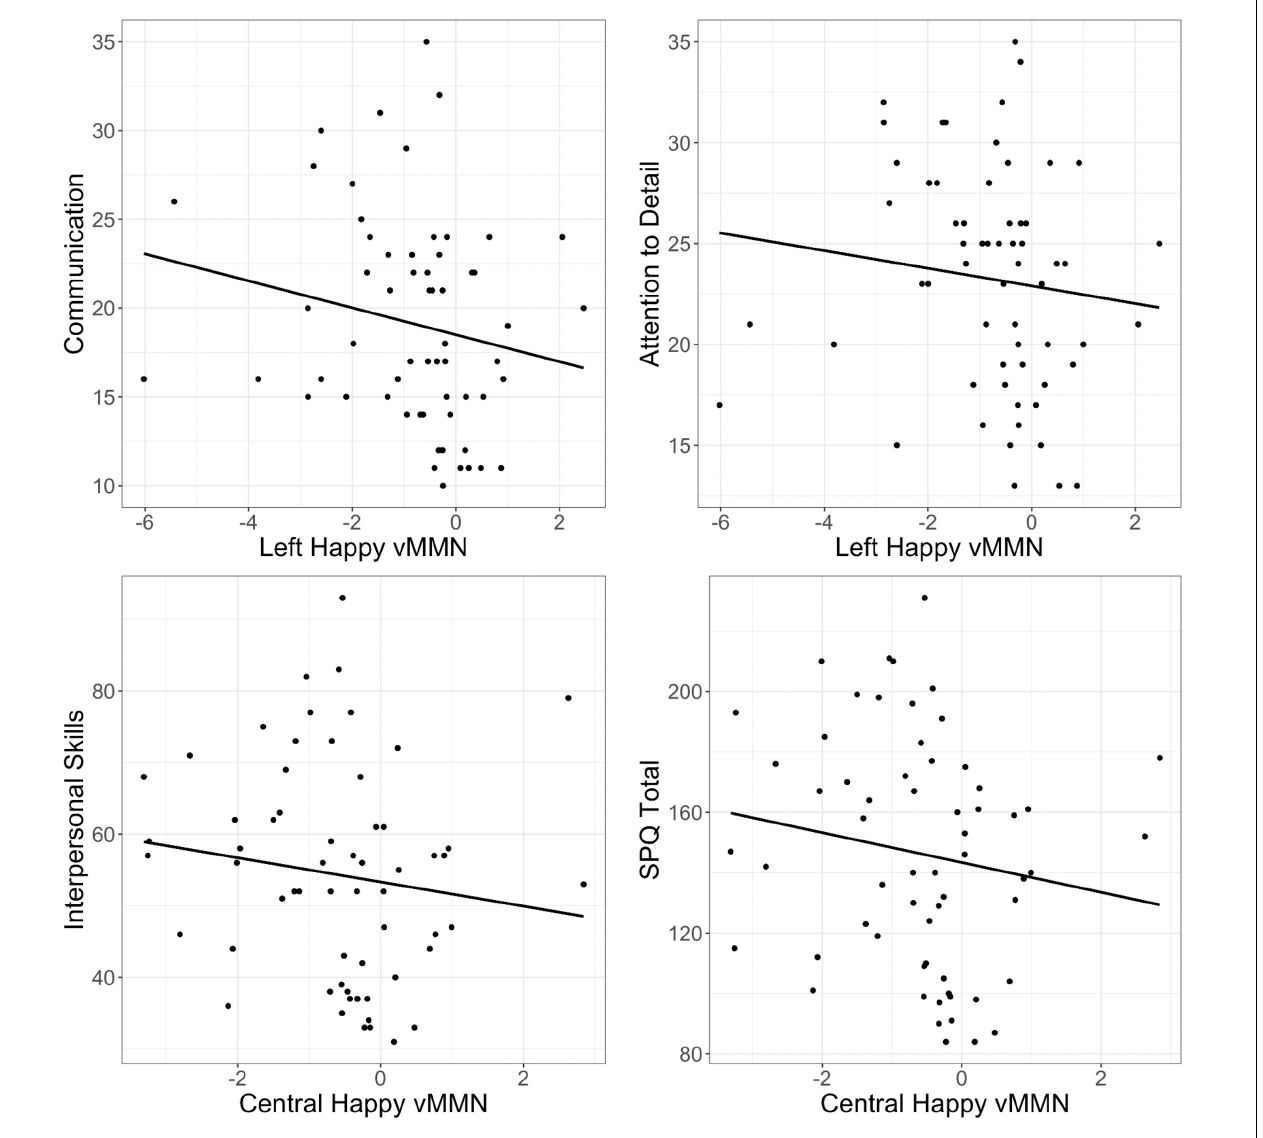
FIGURE 4 | Scatter plots of correlations between left and central visual mismatch negativity (vMMN) amplitude (microvolts; µ V) to happy faces (happy deviant–happy standard) and Communication, Attention to Detail, and Interpersonal subscales, and Schizotypal Personality Questionnaire (SPQ)